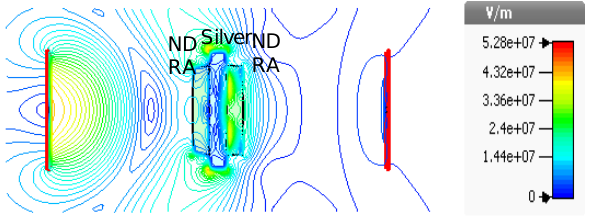
Figure 14 The electric field distribution on the NDR transmitarray unit-cell with silver supporting plane h =50 nm, L =350 nm, h d =50 nm and R =130 nm.